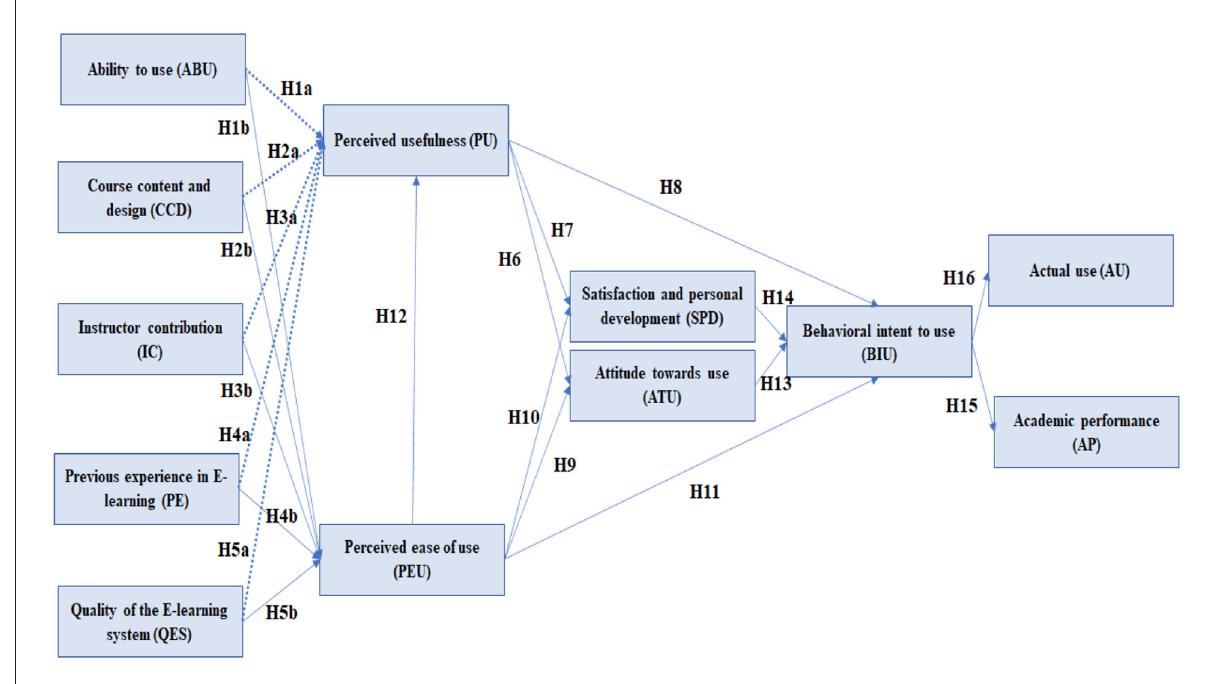
FIGURE2 Hypothesis